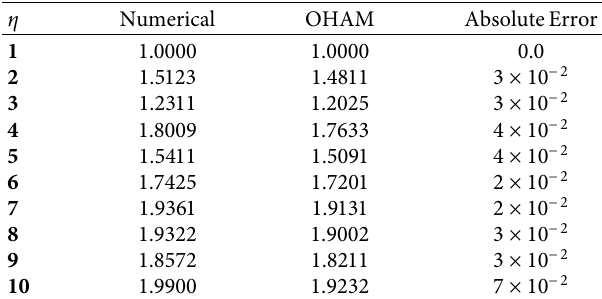
Table 8: Comparison table of analytical method and numerical method for temperature